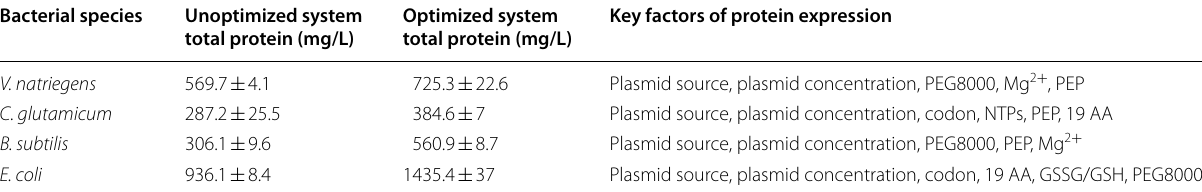
Table 2 Final protein expression levels of the four CFPS systems Bacterial